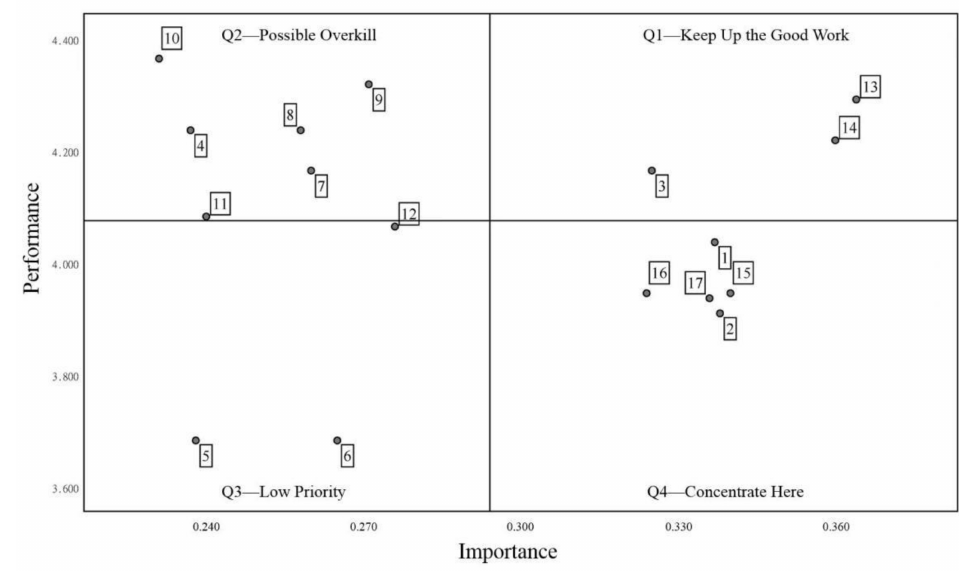
Figure 6. The IPA analysis